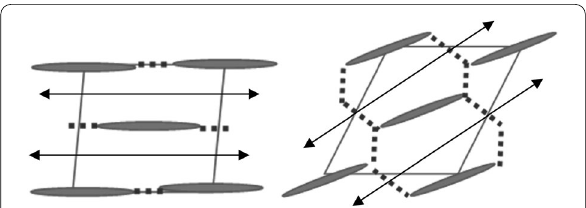
Fig. 9 Schematic diagrams of expected cleavage plane in the crystal lattice for cellulose I (left) and cellulose II (right). Double-headed arrows indicate expected cleavage